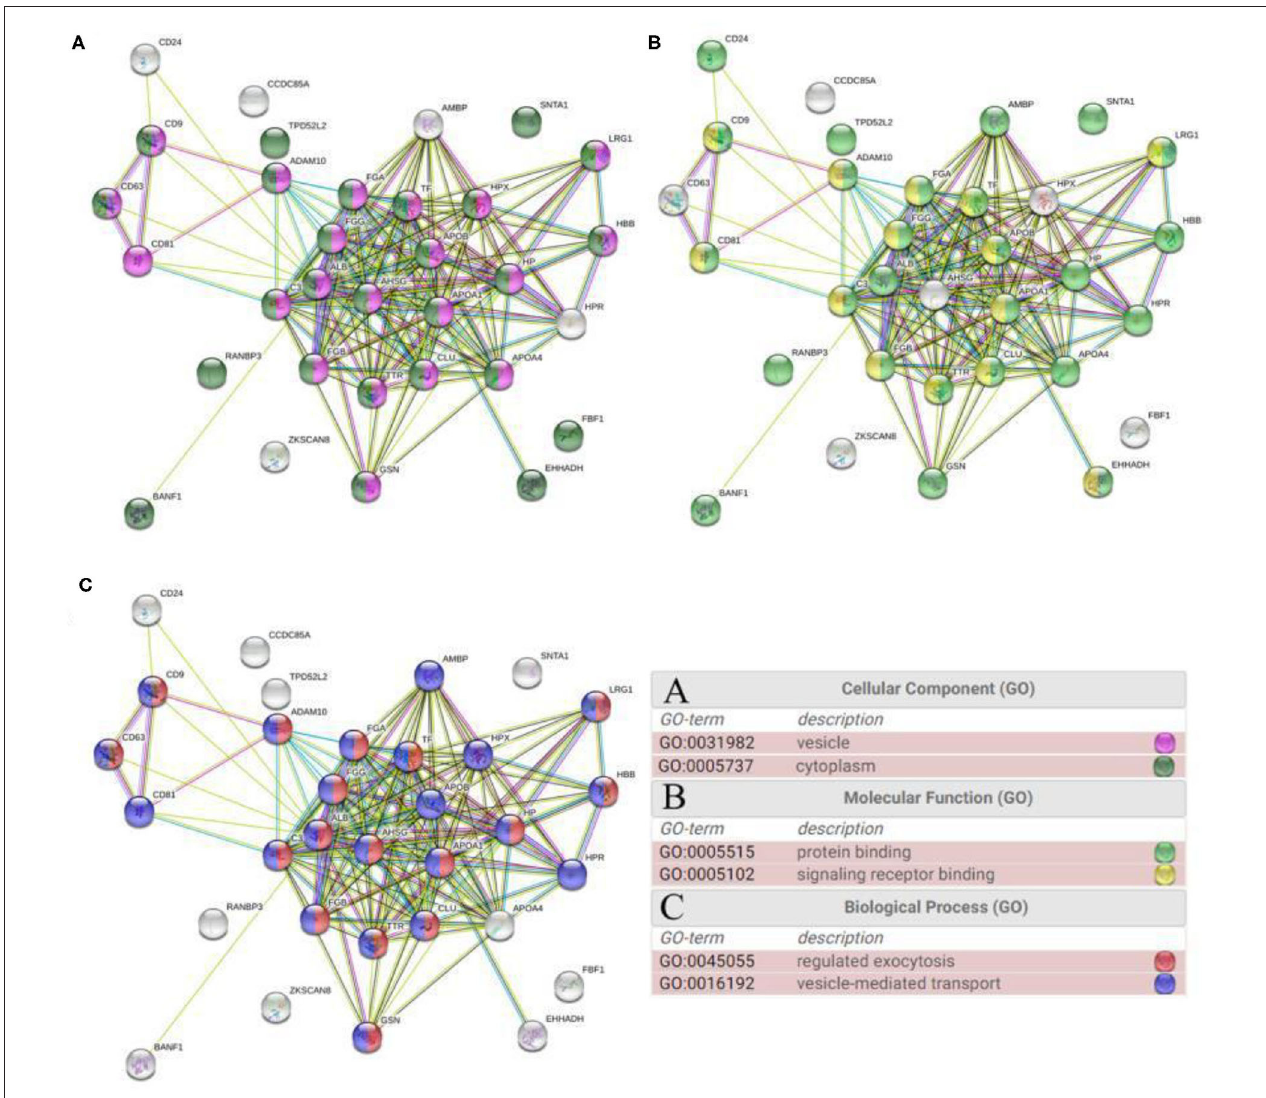
FIGURE 4 | GO functional enrichment analysis of common proteins from total blood exosomes performed using STRING software: (A) cellular component, (B) molecular function, and (C) biological process.